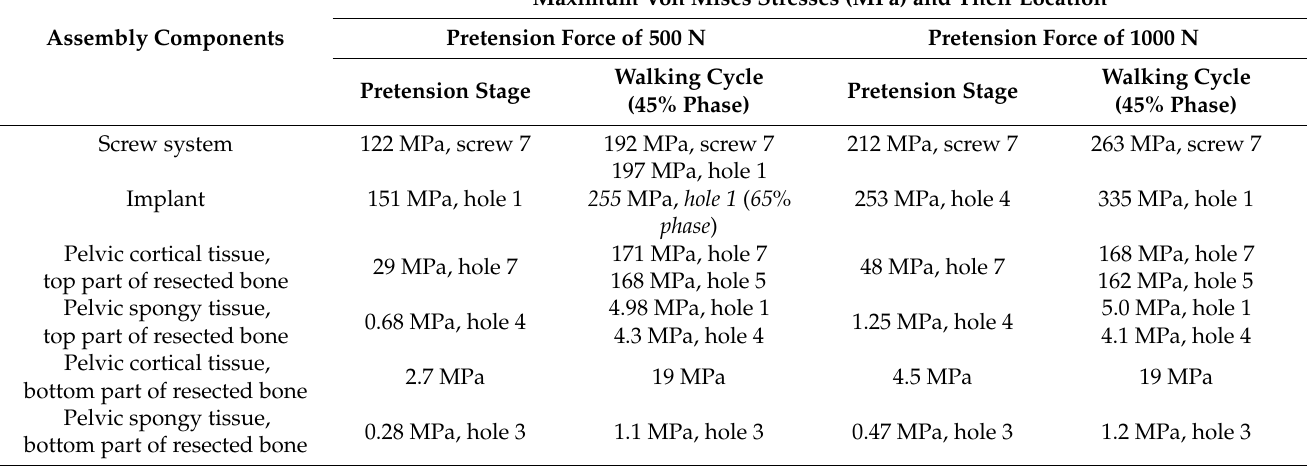
Table 3. Summary of the maximum von Mises stresses occurring in the endoprosthesis parts and bone tissue for screw pretension loads equal to 500 N and 1000 N.